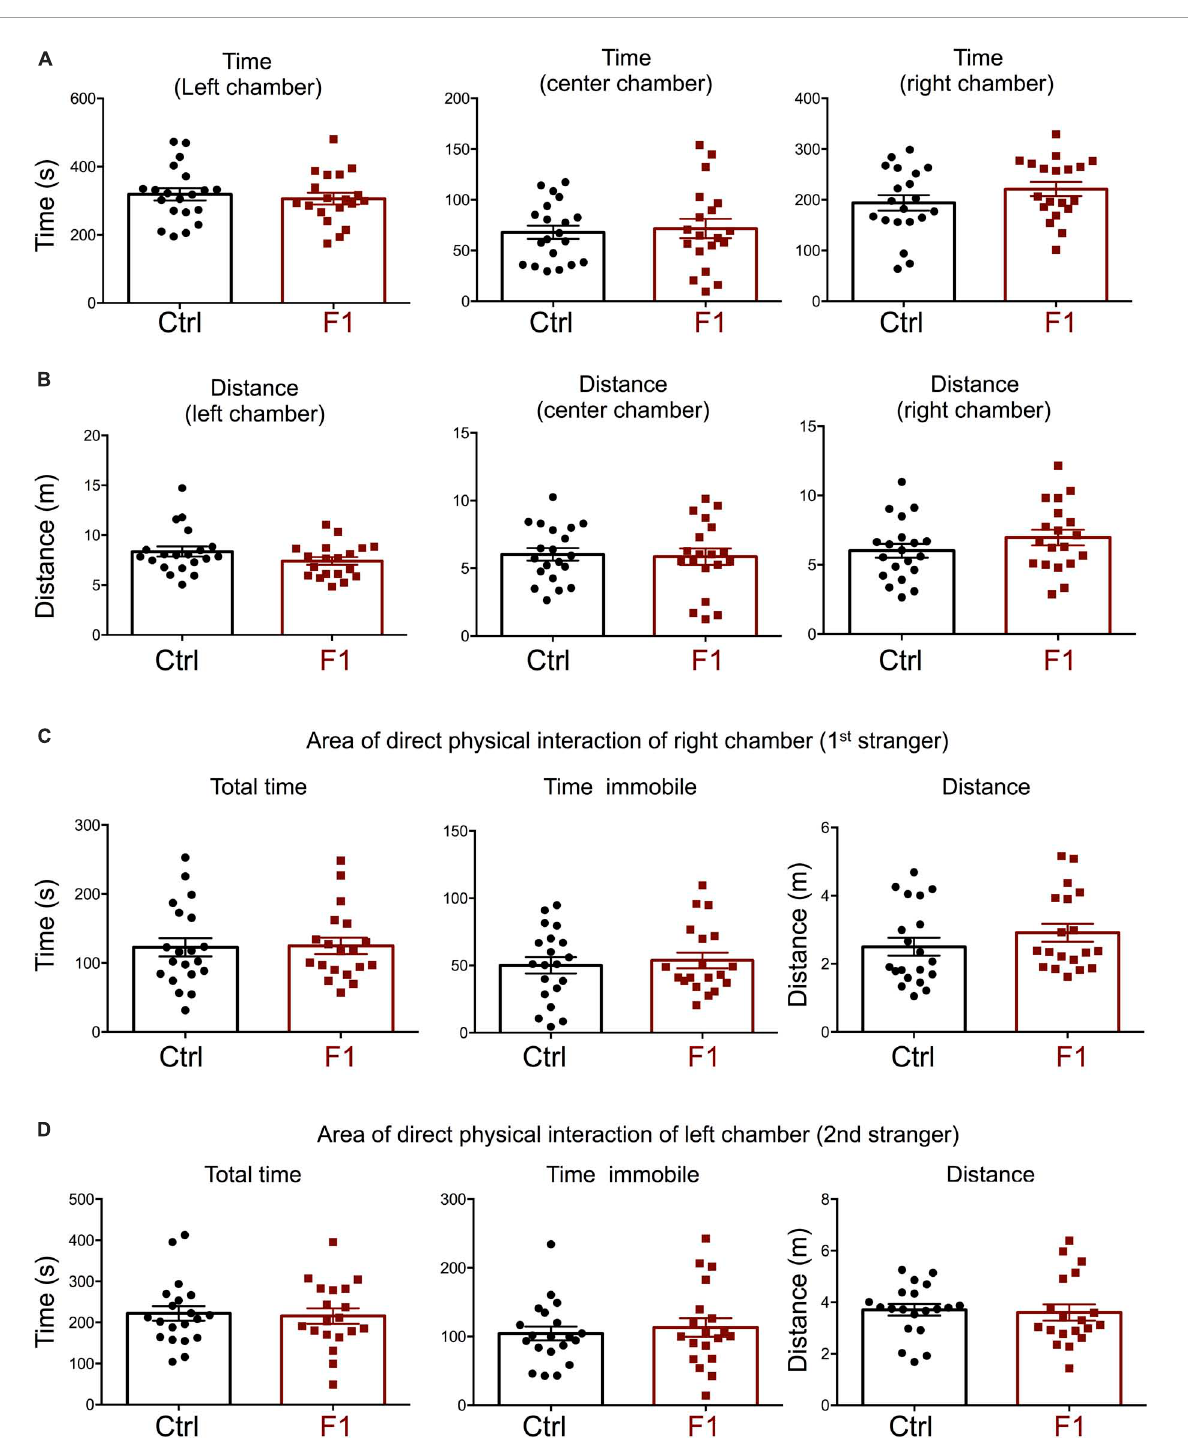
FIGURE6 Interest in social novelty of F1 generation males. (A–C) Second trial of the three-chamber social box test, after first stranger is introduced in the right chamber. (A) Time spent by the test mouse in each chamber. (B) Distance traveled by the test mouse in each chamber. (C) Total time, time immobile, and distance traveled by the test mouse in the area immediately around the 1st stranger in the right chamber. (D) Total time, time immobile, and distance traveled by the test mouse in the area immediately around the 2nd stranger in the left chamber. Each point represents a different mouse tested at approximately 18 weeks of age ( n = 22, 20) and mean ± SEM are shown. Experimental mice from each group represent 4–6 different litters and data represent two animal cohorts that were generated and tested at different